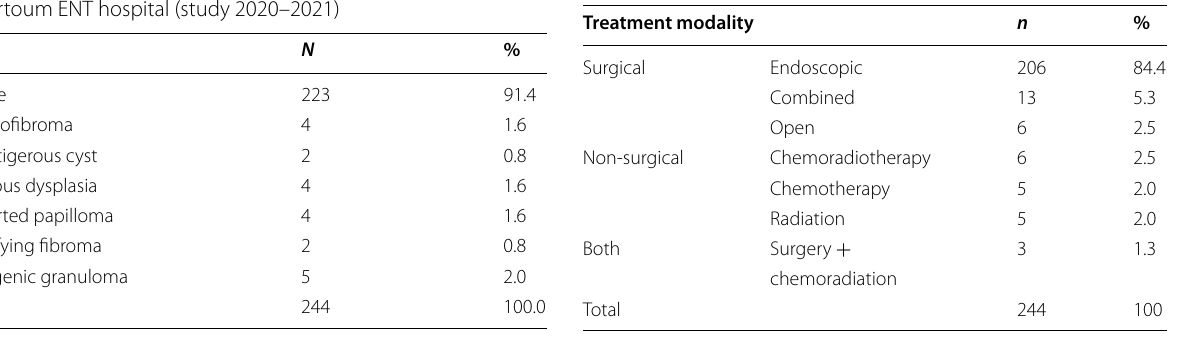
Table 5 Treatment modalities among patients with